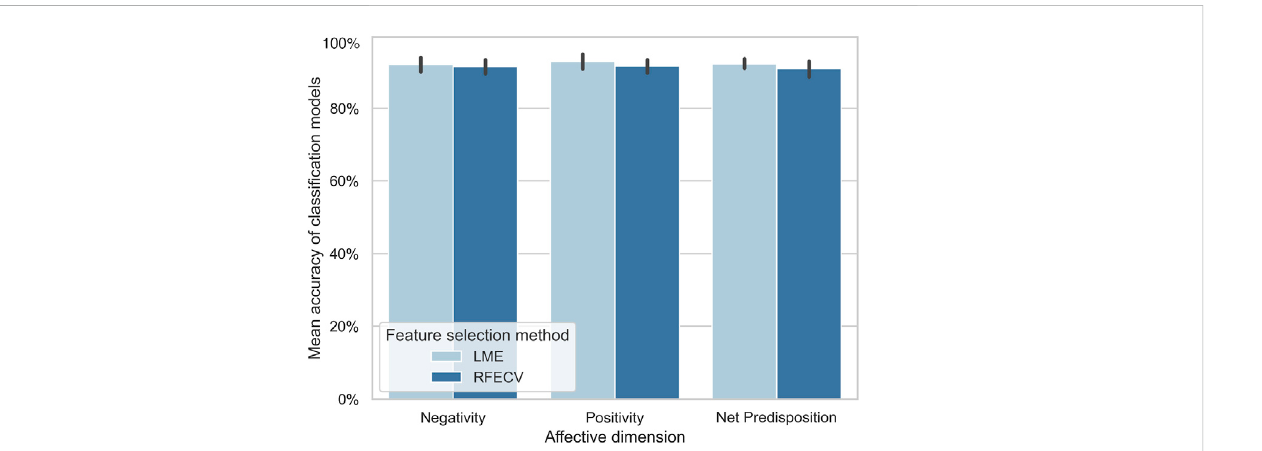
FIGURE 4 Meanaccuracyoftheclassi fi cationmodelsforeachaffectivedimensionoftheESM(Cacioppoetal.,1997).Theaccuracyoftheclassi fi cationmodels trained with features selected using LME was not statistically signi fi cantly different than the accuracy of the models trained with features selected using RFECV. The accuracy of the classi fi cation models was similar across affective dimensions. Error bars depict CI,